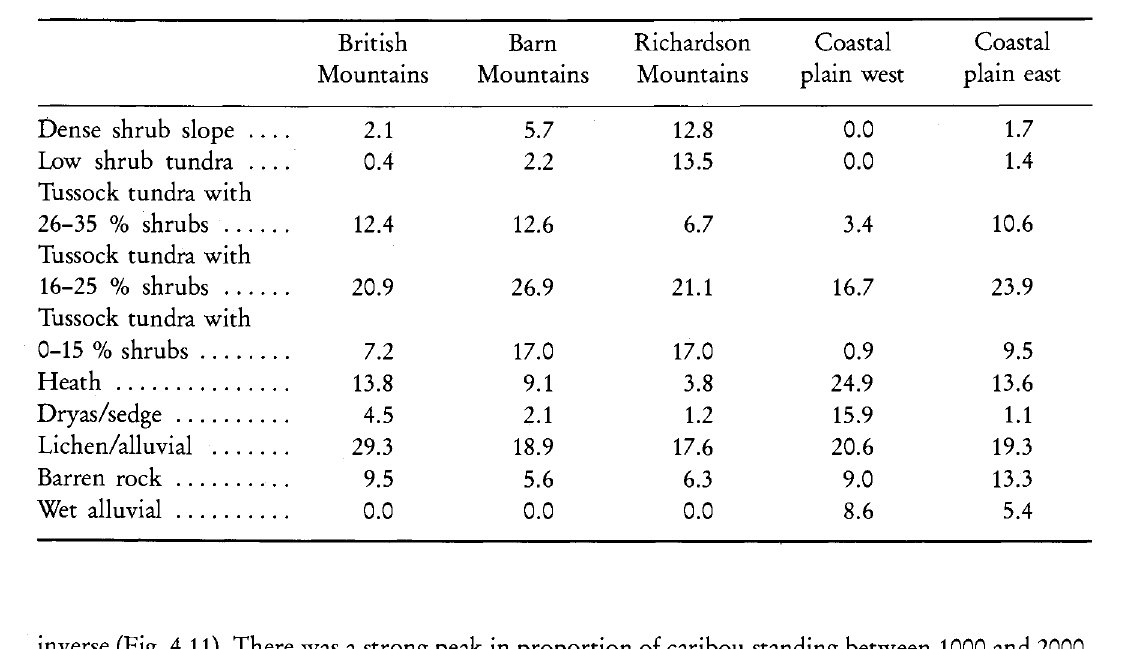
Table 4.7. Percent cover of land cover types found in each sub-region of mapped area. British Barn Richardson Coastal Coastal Mountains Mountains Mountains plain west plain east Dense shrub slope .